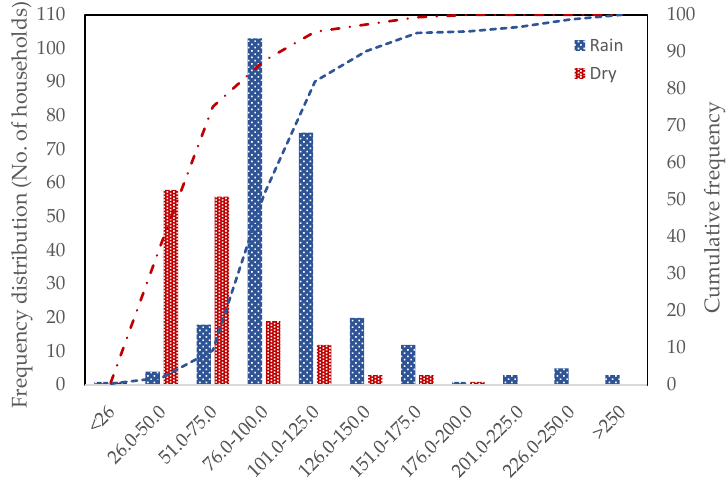
Figure 7. Seasonal variability of per capita average water consumption.